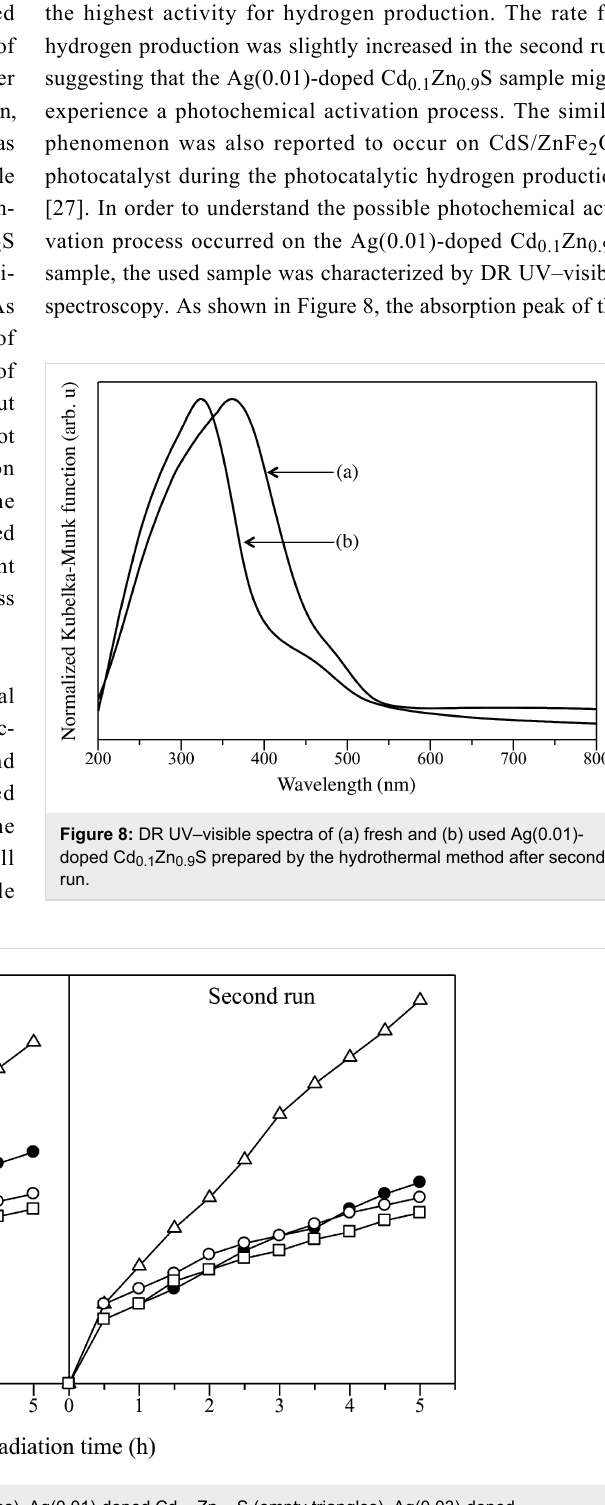
Figure 7: Photocatalytic hydrogen evolution on Cd 0.1 Zn 0.9 S (filled circles), Ag(0.01)-doped Cd 0.1 Zn 0.9 S (empty triangles), Ag(0.03)-doped Cd 0.1 Zn 0.9 S (empty circles), and Ag(0.05)-doped Cd 0.1 Zn 0.9 S (empty squares) prepared by the hydrothermal method under visible-light irradiation.